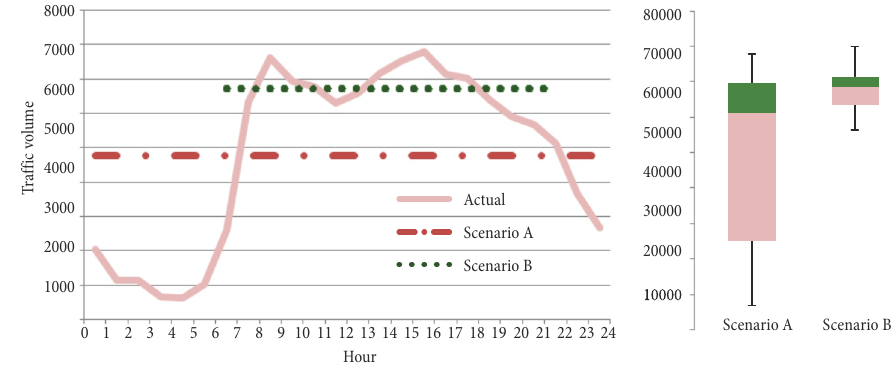
Fig. 6. Variability of traffic volumes